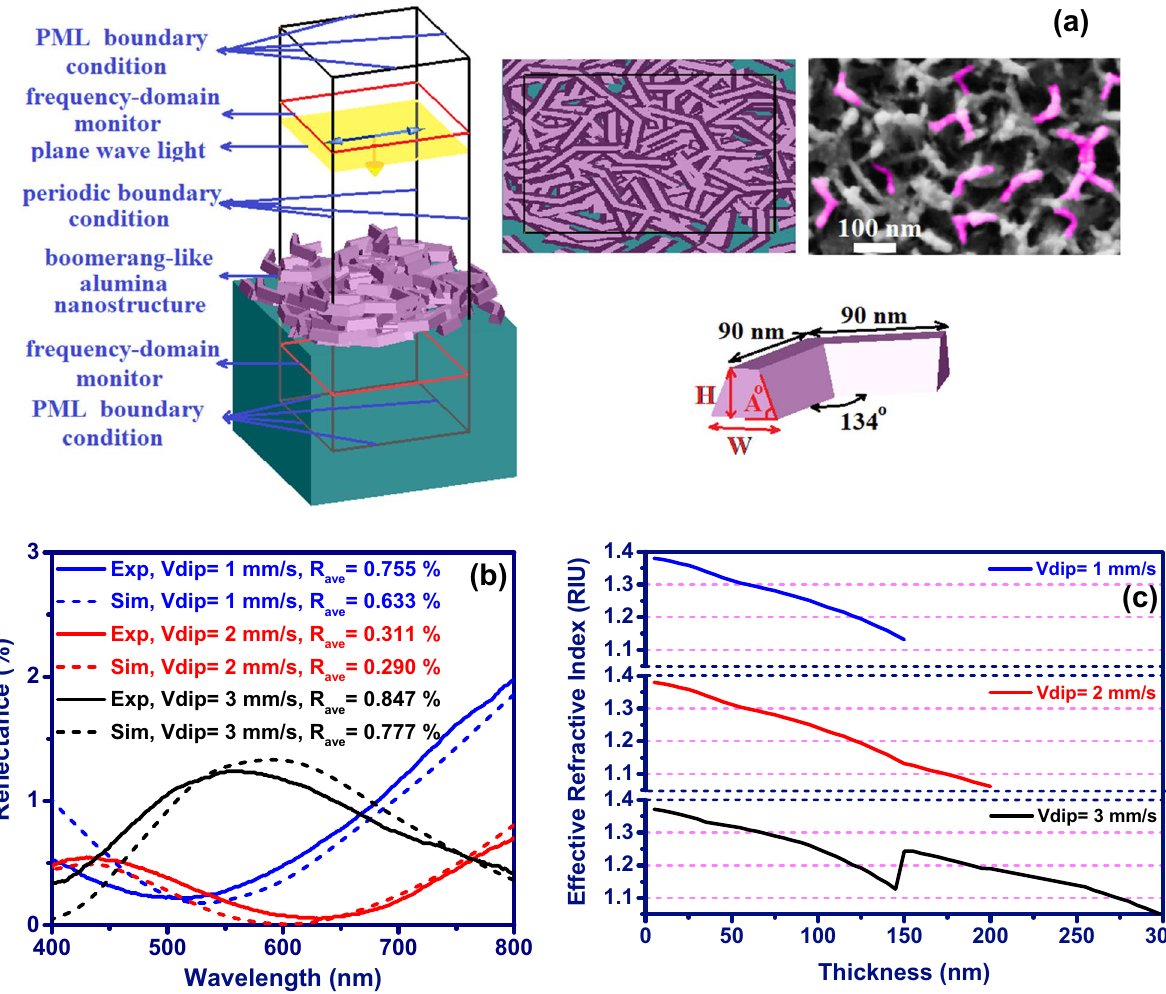
Figure 3. ( a ) Schematic diagram of the simulation model: perspective view (left) and top view (right). ( b ) Spectral reflectance of double side coated samples with different dipping-withdrawing rates (V dip ) from Fig. 2 (solid line) and simulated spectral reflectance (dash line). ( c ) The relationships between thickness position and effective refractive index of boomerang-like Al 2 O 3 films produced at different dipping-withdrawing rates (V dip